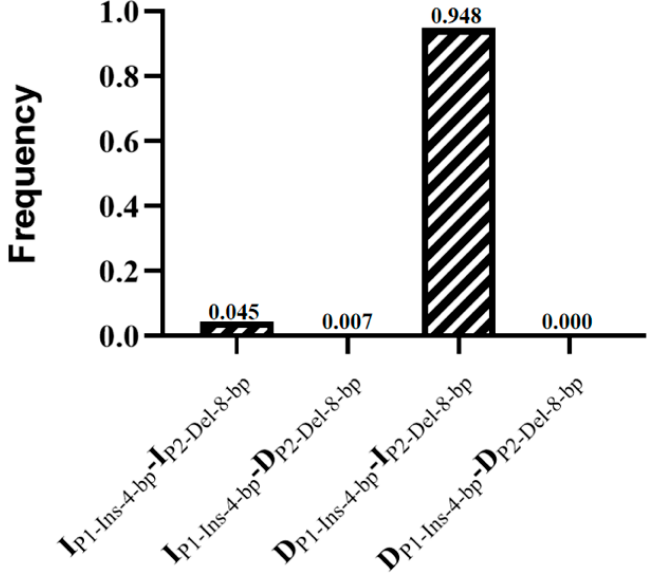
Table 7. Associations of the P2-Del-8-bp InDel with carcass traits in different genders of the SDBCGR population. Carcass Traits Figure 9. Haplotype frequencies of the HOXA11 gene in the SDBCGR population. Figure 9. Haplotype frequencies of the HOXA11 gene in the SDBCGR population.